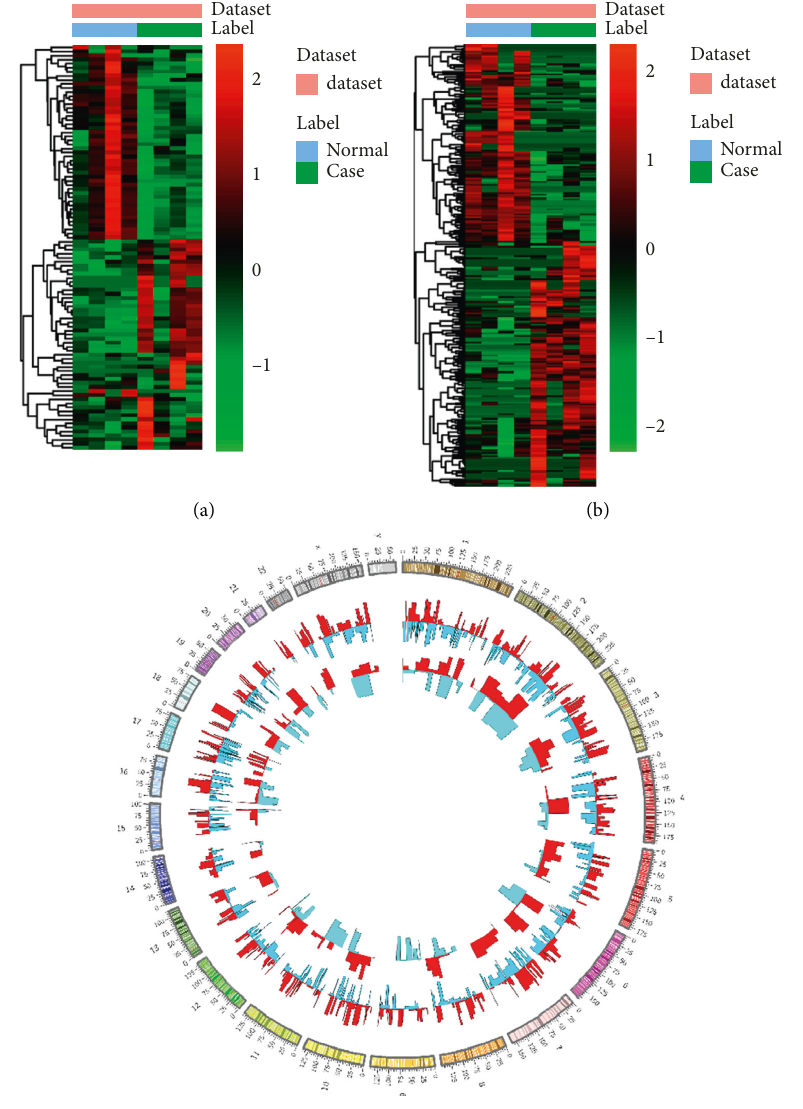
Figure 1: Heatmap of top 100 mRNAs and all lncRNAs in luminal A breast cancer. (a) DEmRNAs, (b) DElncRNAs, and (c) Circos plots represent the distribution of DElncRNAs and DEmRNAs on chromosomes. The outer layer cycle is the chromosome map of the human genome. The inner layers represent the distribution of DEmRNAs and DElncRNAs on different chromosomes, respectively. Red and blue colors represent upregulation and downregulation,